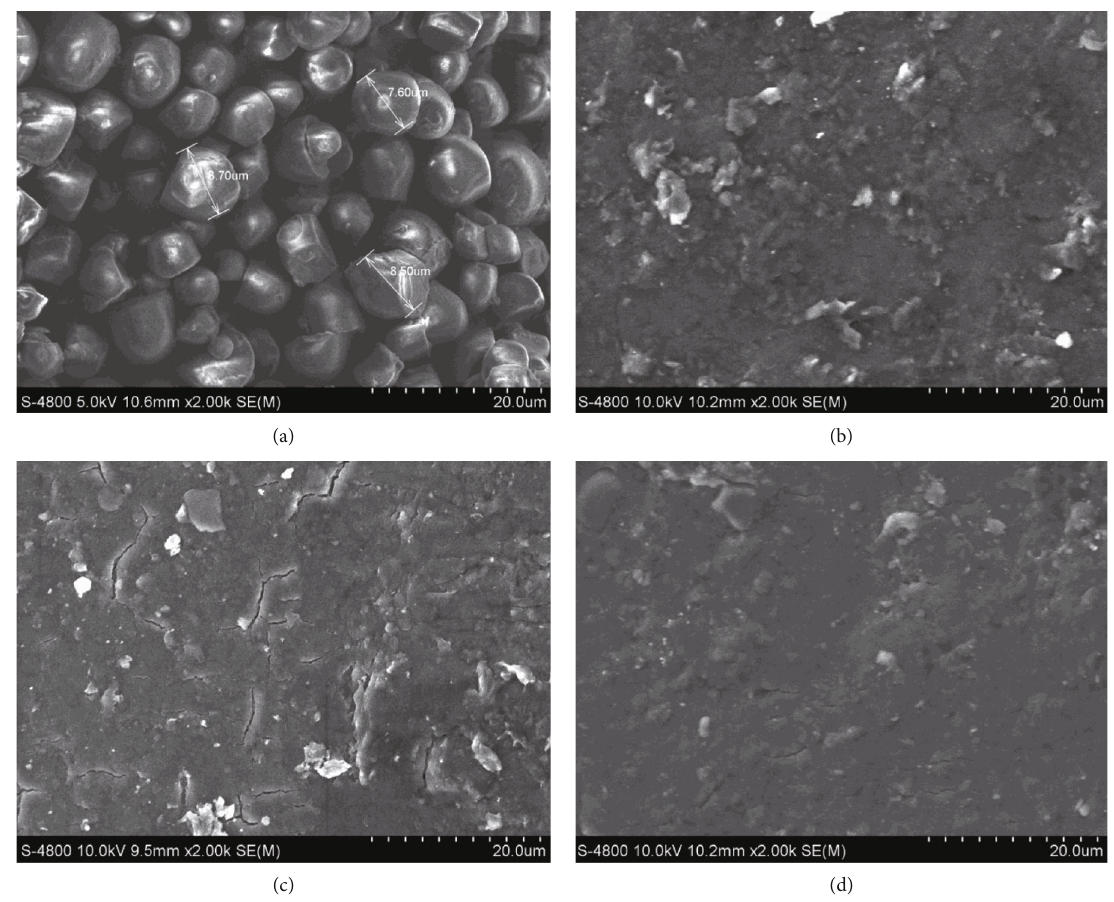
Figure 7: SEM characterization with 2000 times magni fi cation. (a) Starch from jackfruit seed. (b) Bioplastic with ratio 2.5:1. (c) Bioplastic with ratio 3:1. (d) Bioplastic with ratio 3.5 :1.